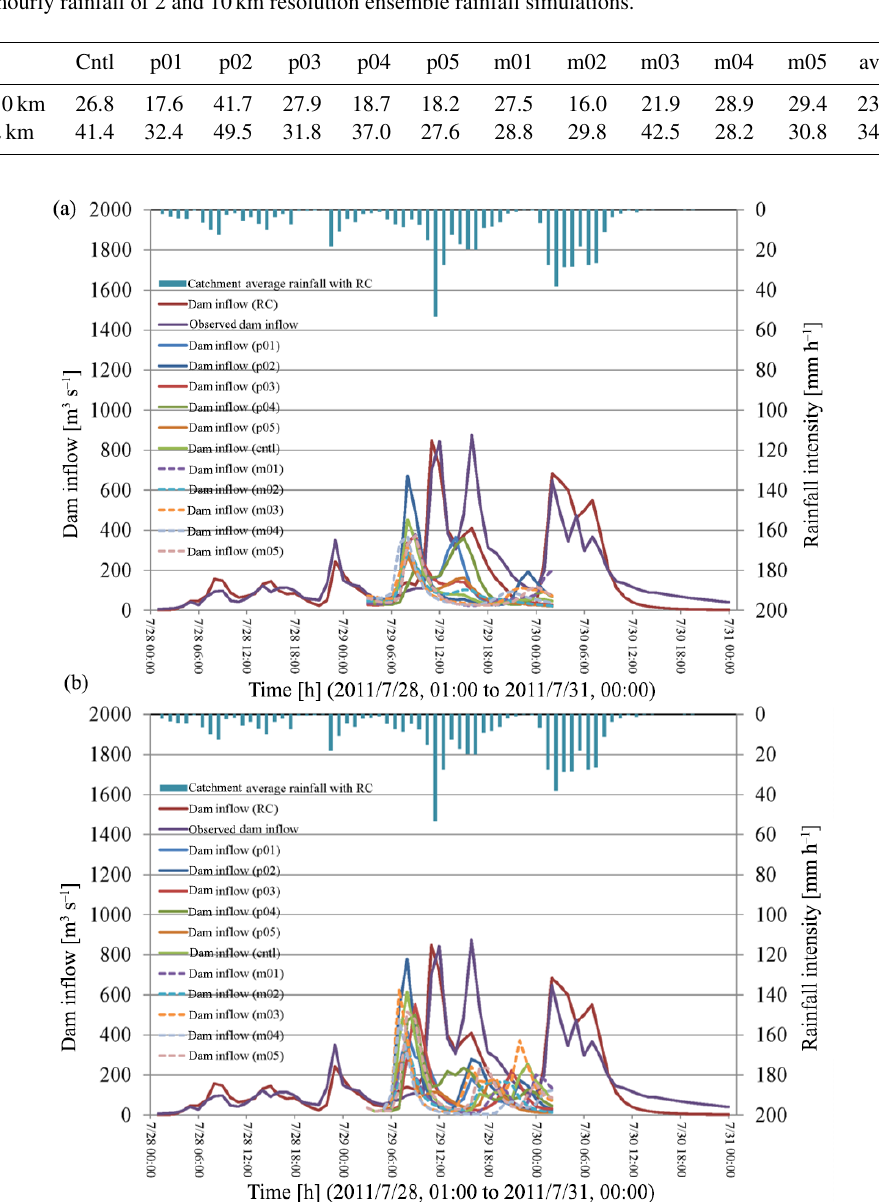
Table 3. Maximum hourly rainfall of 2 and 10km resolution ensemble rainfall simulations.